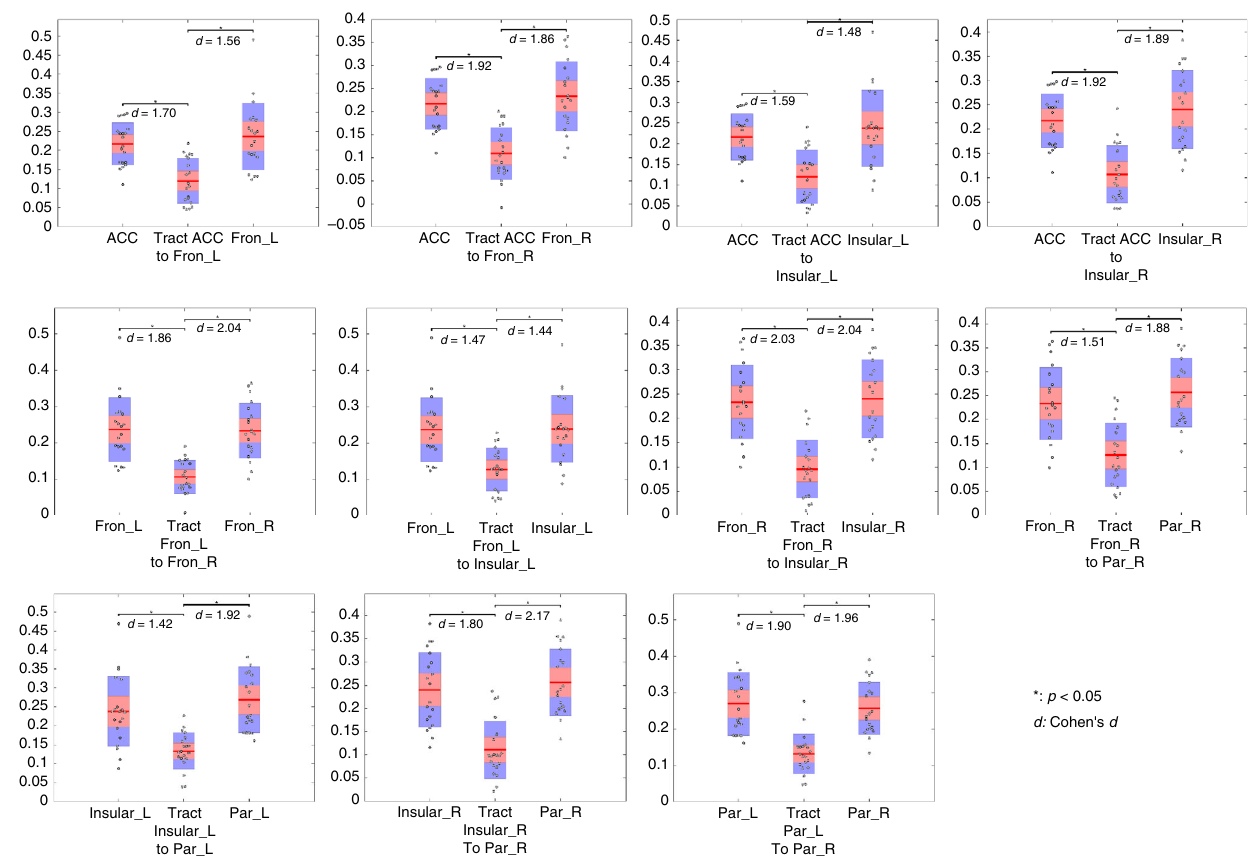
Fig. 5 The average magnitudes of WM tracts and their connecting GM clusters. The average magnitude of one WM tract was displayed in the center of each panel with the average magnitudes of its connecting GM clusters on either side. The y -axis is the peak magnitude of the signal intensity (a.u.). Points are laid over a 1.96 SEM (95% con fi dence interval) in red, a 1 SD in blue and a center line that denotes the median. All WM tracts showed signi fi cantly decreased magnitudes ( P < 0.05, t -test) in comparison with their connecting GM clusters. Source data are provided as a Source Data fi le